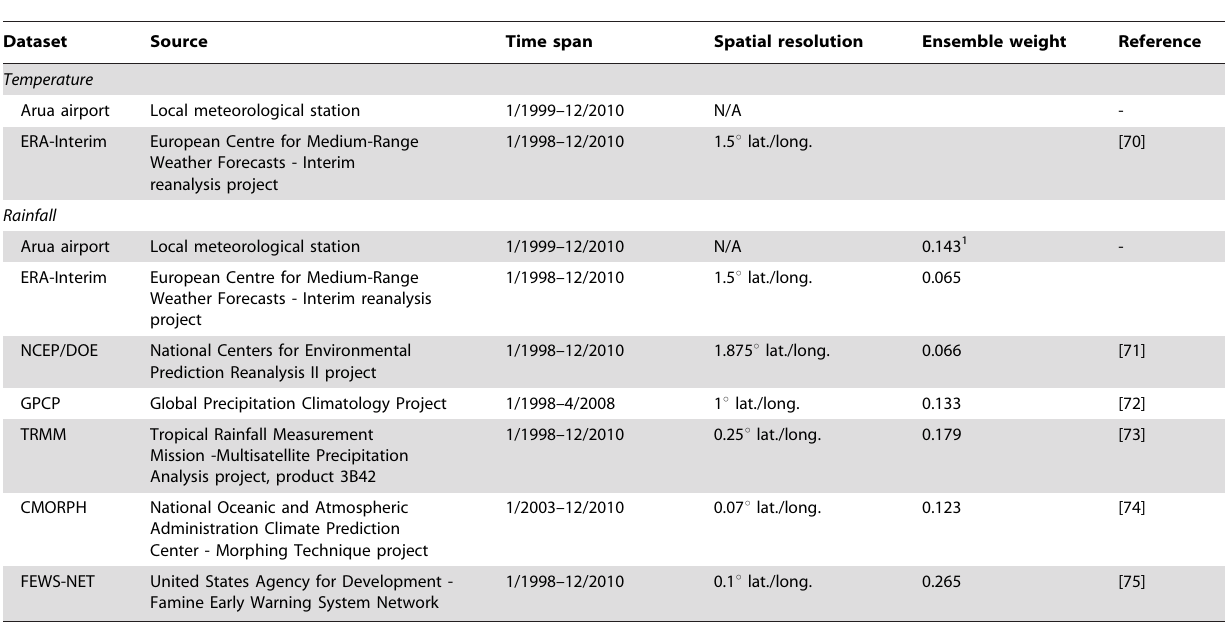
Table 1. Meteorological datasets used in analysis of the interannual variation of suspect plague cases.